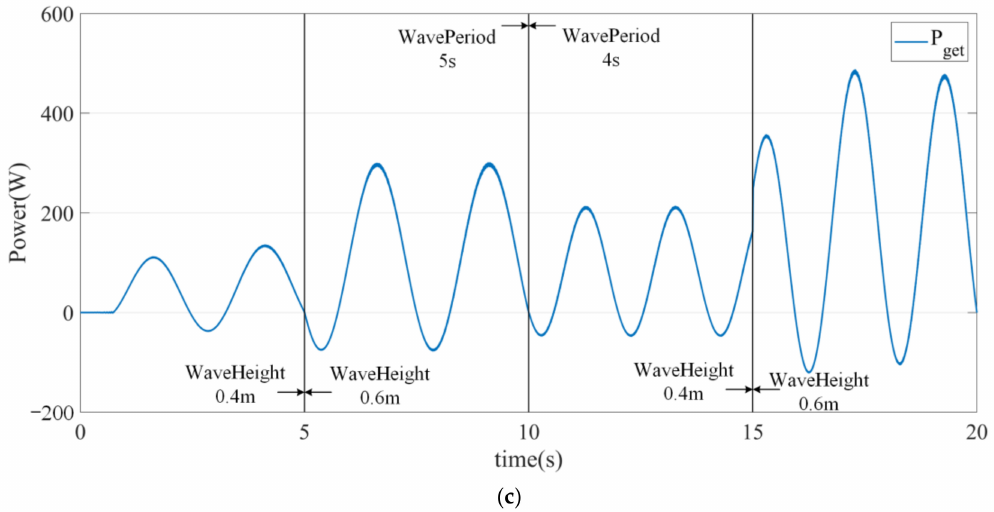
Figure 13. Electrical and mechanical dynamic response at different sea conditions: ( a ) Q -axis current of generator at different sea conditions; ( b ) three phase currents of generator at different sea conditions; ( c ) power capture in generator at different sea